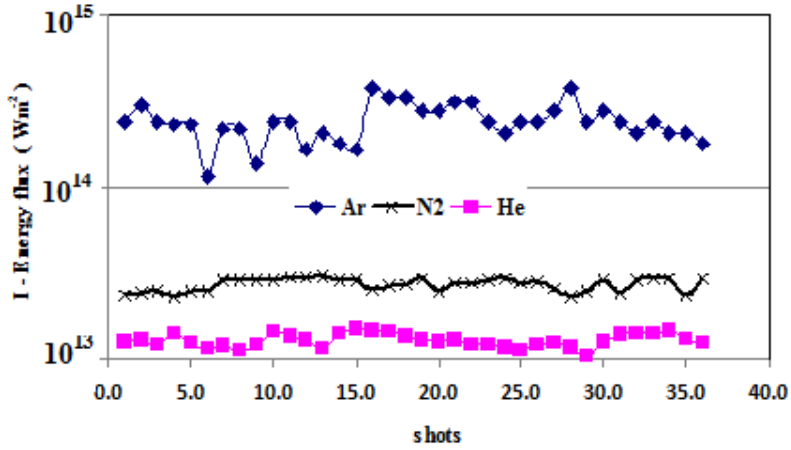
Figure 5. AECS PF-1 ion energy flux for 36 shots at 0.6 Torr for He, N 2 , and Ar gases.